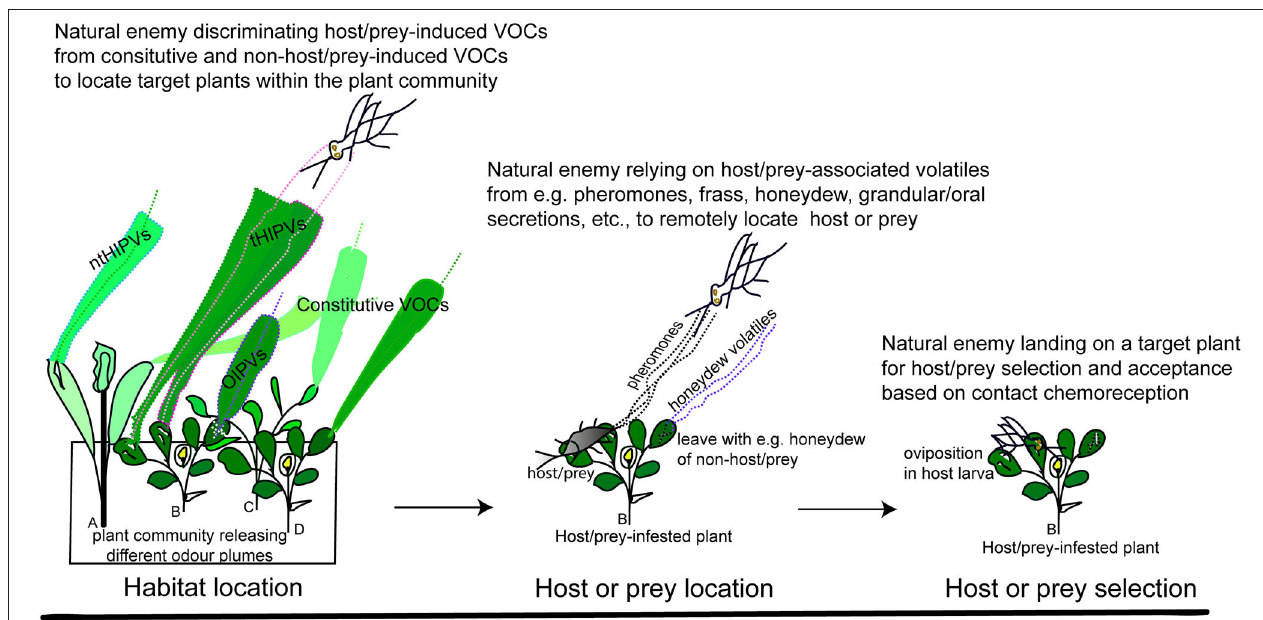
FIGURE 2 | Schematic description of the use of kairomones during foraging behavioural sequences involved in host/prey searching by parasitoids and predators. VOCs, volatile organic compounds; tHIPVs, target herbivore-induced plant volatiles; ntHIPVs, non-target herbivore-induced plant volatiles; OIPVs = oviposition-induced plant volatiles. Plant community composed of (A) infested non-host plants; (B) infested host plants; (C) uninfested non-host plants; and (D) uninfested host